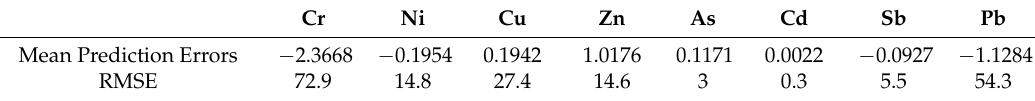
Table 2. Accuracy evaluation of the spatial